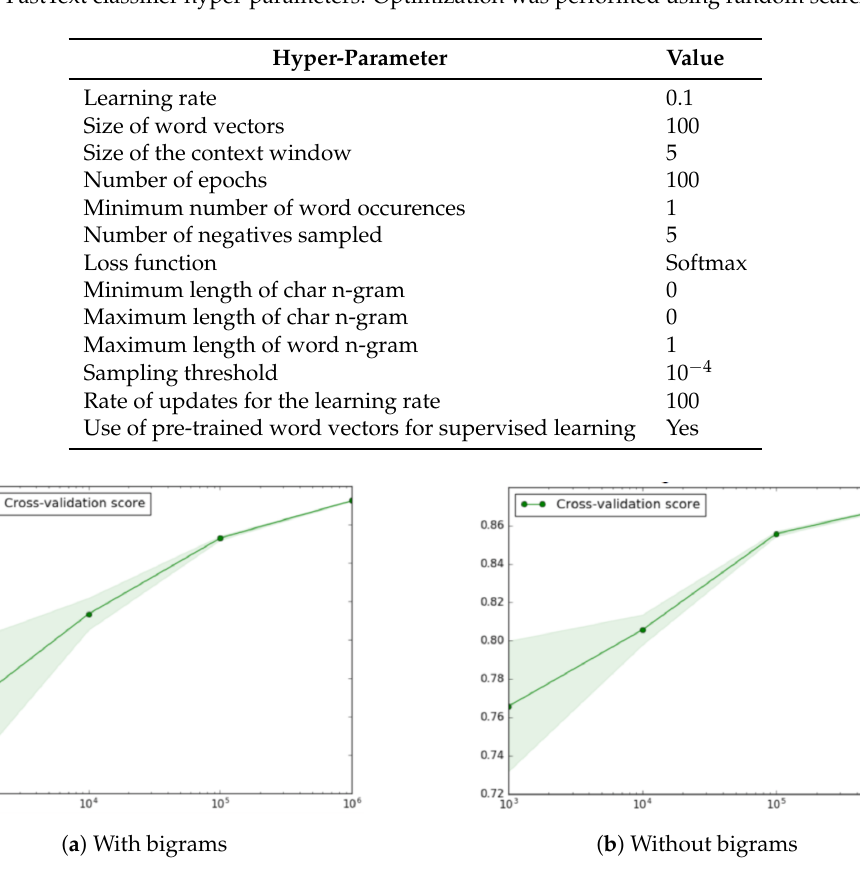
Table 4. FastText classifier hyper-parameters. Optimization was performed using random search [22].